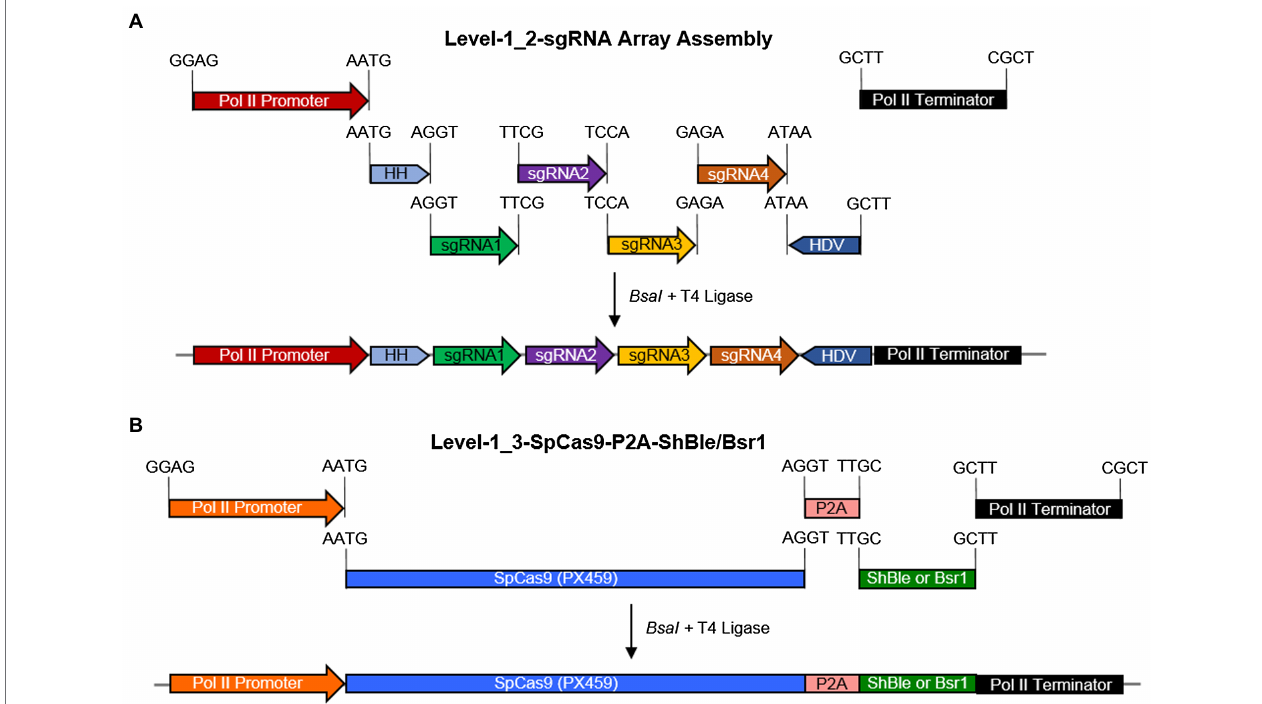
FIGURE 1 | A schematic diagram for the assembly of Level-0 Universal Loop parts into Level-1 transcriptional units and the final assembly of a Level-2 CRISPR/ Cas9 diatom episome in the pCA plasmid kit. (A) a pCA-Level-1_2-sgRNA array was assembled in a Level-1 Golden Gate reaction with the BsaI enzyme and T4 DNA ligase for 30 cycles by combining Level-0 parts and sgRNA fragments with indicated overhangs. (B) A pCA-Level-1_3-SpCas9-P2A- Sh Ble/ Bsr1 transcriptional unit was assembled in a Level-1 Golden Gate reaction with the BsaI enzyme and T4 DNA ligase for 25 cycles by combining Level-0 parts with indicated overhangs. Promoter-terminator combination used for the sgRNA array is not reused for Sp Cas9-P2A- Sh Ble/ Bsr1 in the same Level-2